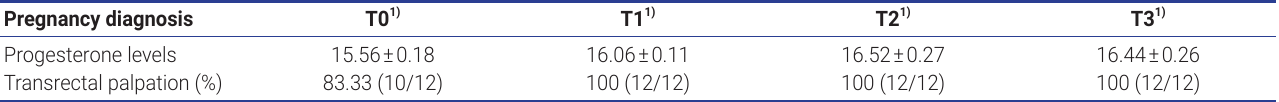
Table 4. The average serum progesterone levels (ng/mL) at day 21 of pregnant cows (mean±SE) and the pregnancy rate of cow recipients based on transrectal palpation at day 90 post-AI using frozen semen in SM-EY extender, with the addition of GTE at various